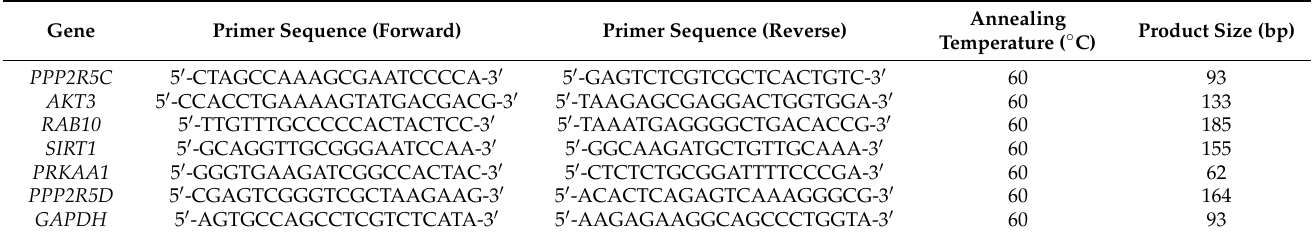
Table 2. Oligonucleotide primer sequences for quantitative reverse transcriptase polymerase chain re-